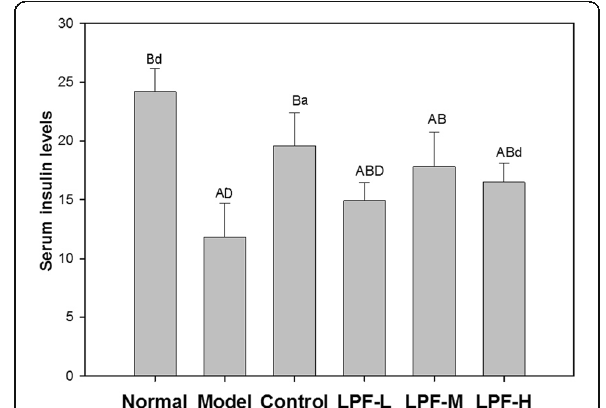
Fig. 5 Effects of LPF on insulin levels. The results were expressed as mean ± SD (n = 8/group). A p < 0.01, a p < 0.05, compared with normal group; B p < 0.01, b p < 0.05, compared with model group; D p < 0.01, d p < 0.05, compared with control